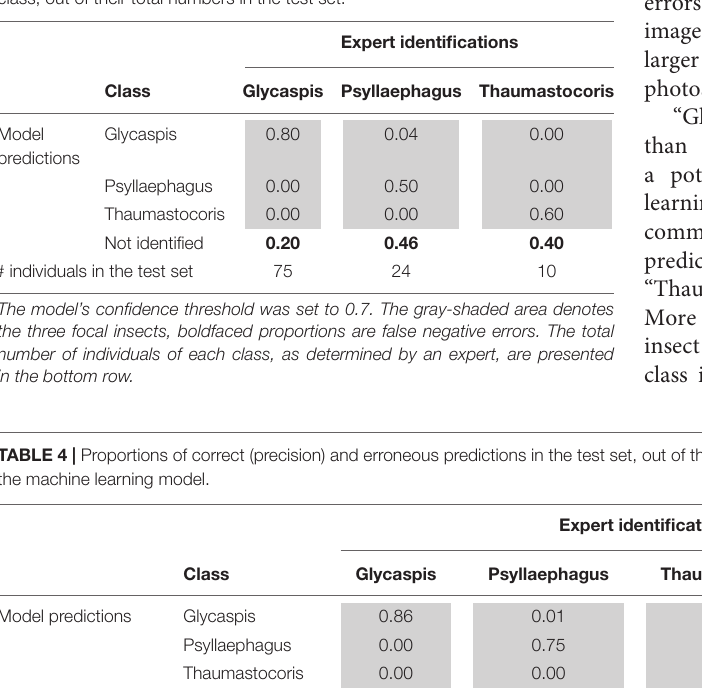
TABLE 3 | Proportions of correct (recall) and erroneous predictions of each insect class, out of their total numbers in the test set.